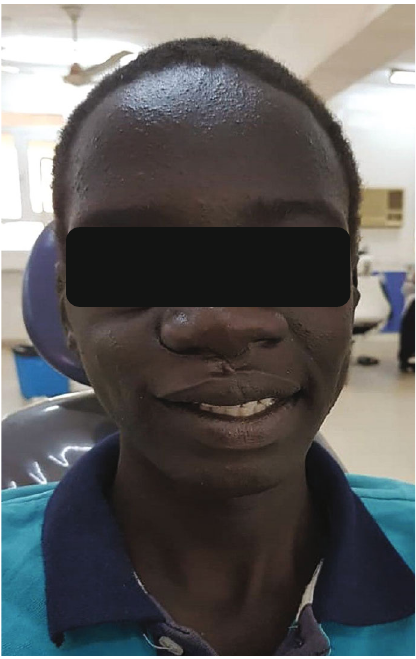
Figure 4: Postoperative frontal view of the patient wearing the lip and cheek plumper having and having better